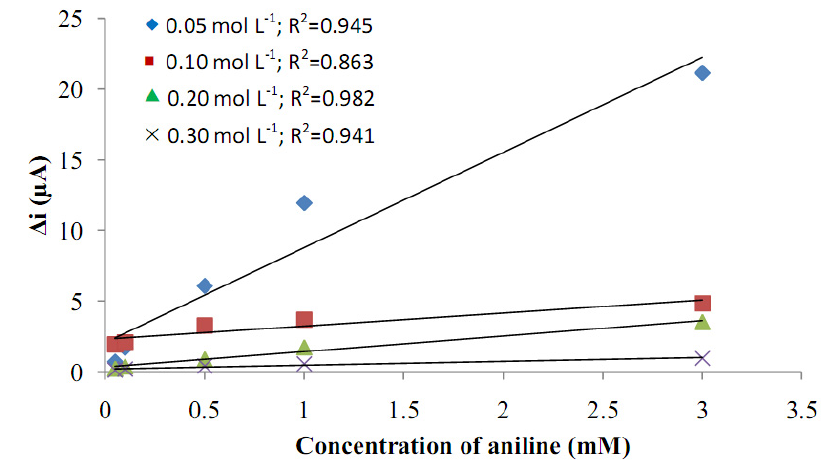
Figure 2. Effect of aniline concentration on the response of the Pt/Pani-Pvs electrode to hydrogen peroxide.